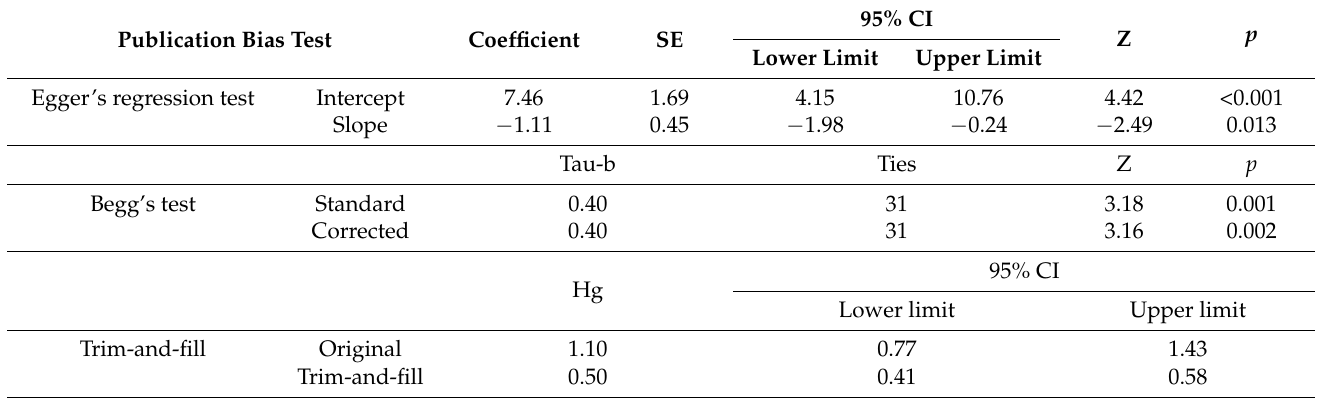
Table 7. Publication bias test evaluating intervention programs and treatment